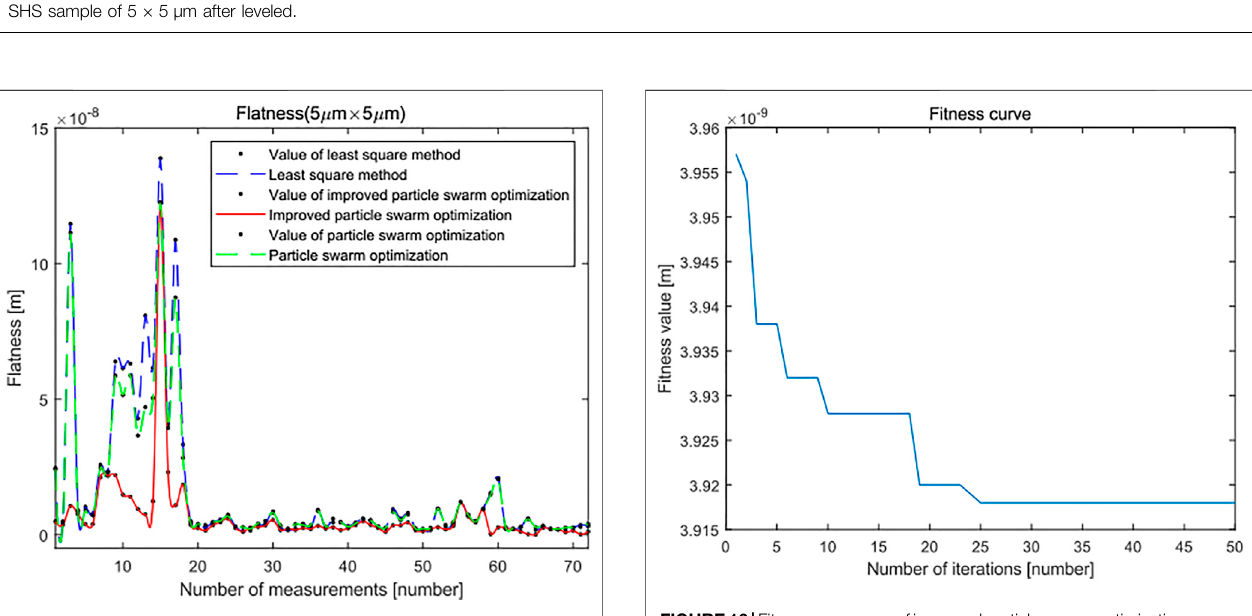
FIGURE 14 | Flatness error evaluation of the SHS sample of 5 × 5 μ m.